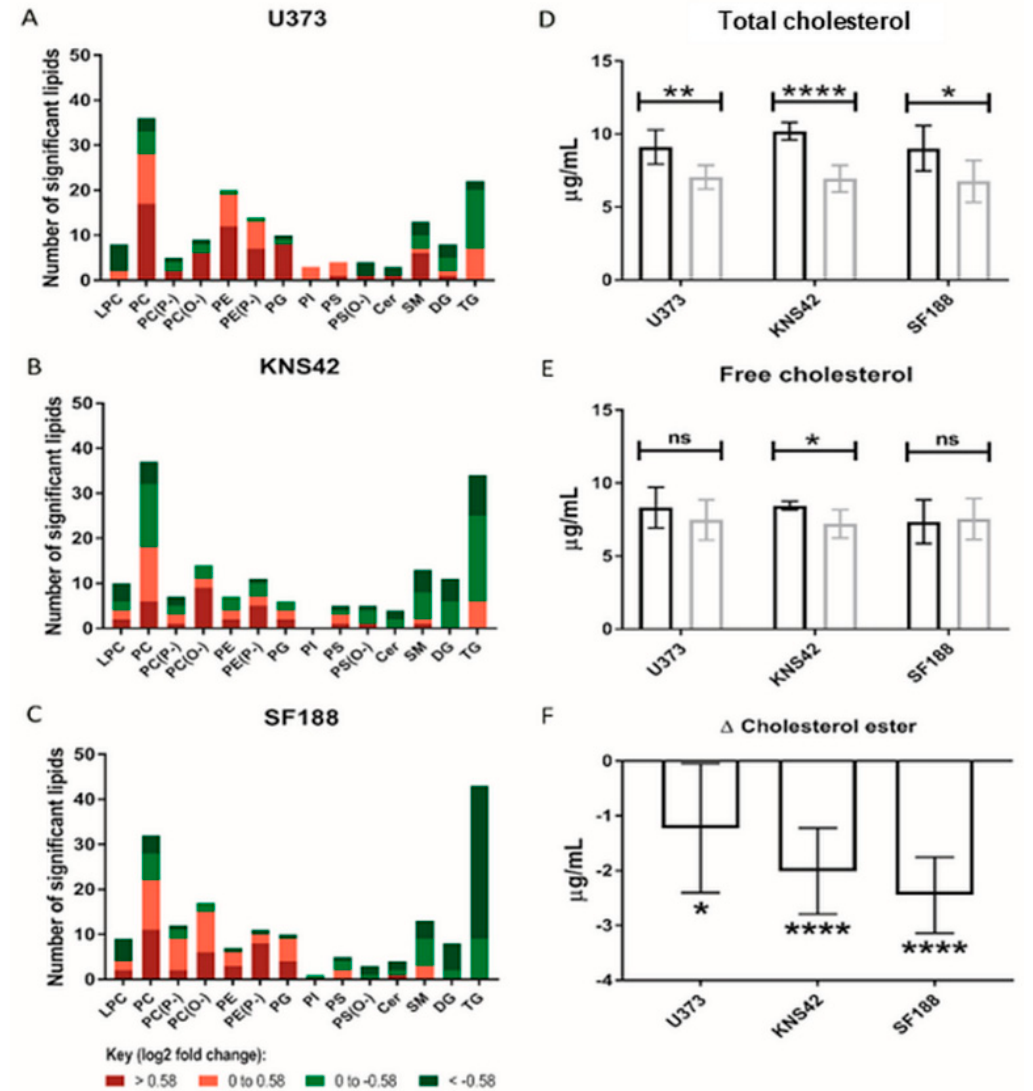
Figure 4. Lipid and cholesterol alterations under lipoprotein-deplete conditions. ( A – C ) Number of each lipid species significantly altered between lipoprotein-replete and -deplete conditions in U373, KNS42, and SF188 diffuse glioma cells, respectively. Colours represent different categories of log2- fold peak intensity changes, with dark red and dark green representing fold changes of 1.5 and 0.67, respectively. ( D , E ) Measurement of the total and free cholesterol concentrations in diffuse glioma cells under lipoprotein-replete (black) and -deplete (grey) conditions. ( F ) The change in concentration of cholesterol ester in each cell line upon lipoprotein starvation was calculated from the concentrations of total and free cholesterol. Results are the mean ± SD of n = 6 independent replicates. Statistical evaluation of differences between the two culture conditions was conducted using t -tests: ns =